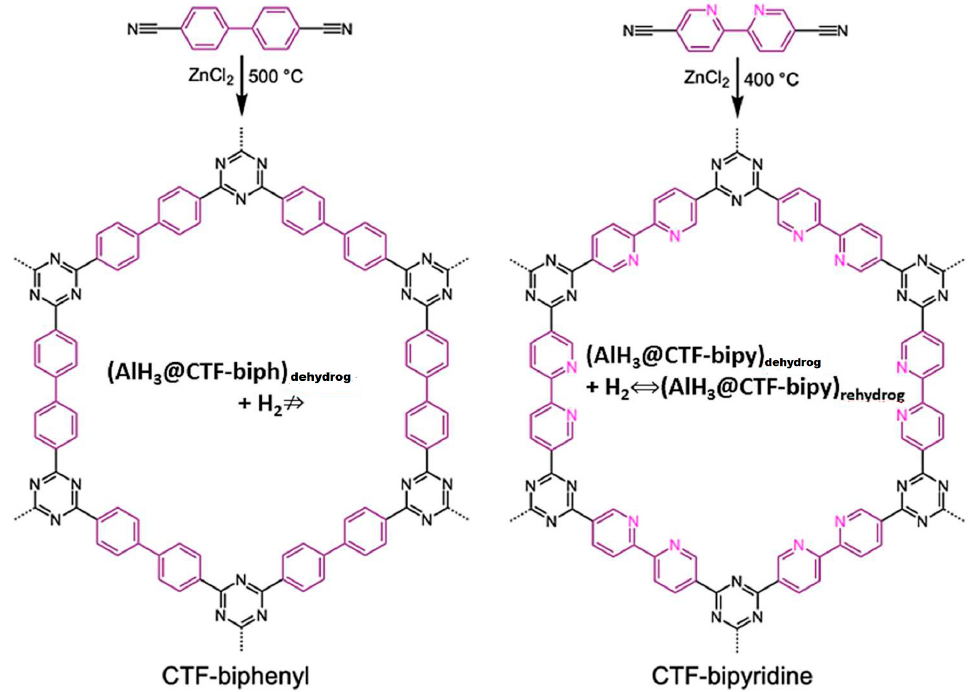
Figure 17. Construction of triazine-type CTF-biph and CTF-bipy used for alane nanoconfinement. Reversibility was only achieved for AlH 3 @CTF-bipy, presumably due to Al-complexation to N-atoms of bipyridyl moieties (shown inside the CTF frame). Reprinted/adapted with permission from [51].